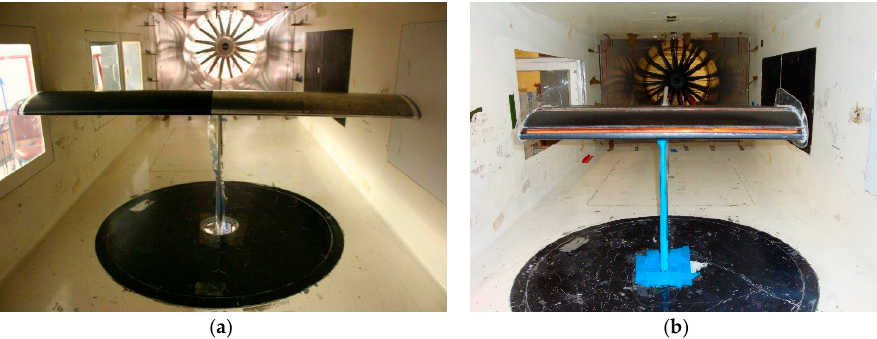
Figure 3. ( a ) Wide and ( b ) narrow fiberglass wing. (Reprinted from